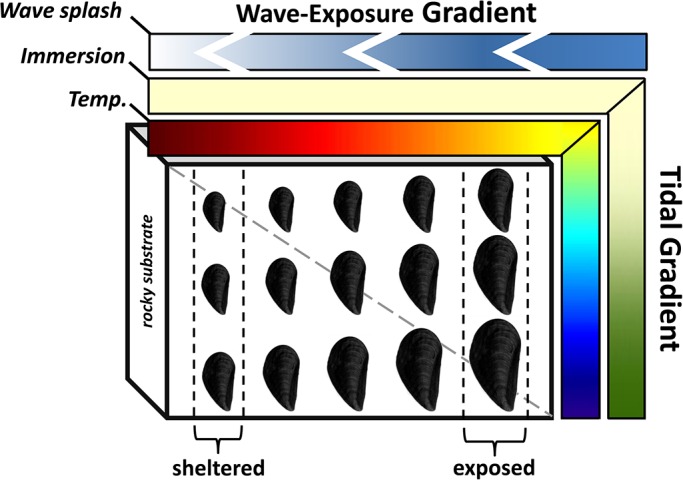
Schematic showing the effects of environmental and biological gradients on growth in M. californianus. Mussels are attached to a rocky substrate (cubed solid) at three shore levels subjected to a tidal (vertical) and wave-exposure (horizontal) gradient. A wave splash gradient (top color bar) persists from right to left (indicated by direction of chevrons) creating wave-exposed and wave-sheltered segments of shore. Intensity (blue color) attenuates from right to left. An immersion gradient (indicated by green color) persists along the tidal gradient. No gradient (solid color) in immersion exists along the wave-exposure gradient. Temperatures increase continuously (from blue to red) up-shore and towards the sheltered. Similarly, growth rates and body sizes (indicated by size of mussel in the cartoon) vary along the tidal gradient and the wave-exposure gradient. The tidal gradient and the wave exposure gradient are not independent because waves splash water up-shore as well as along-shore (gray diagonal line across the rocky solid).